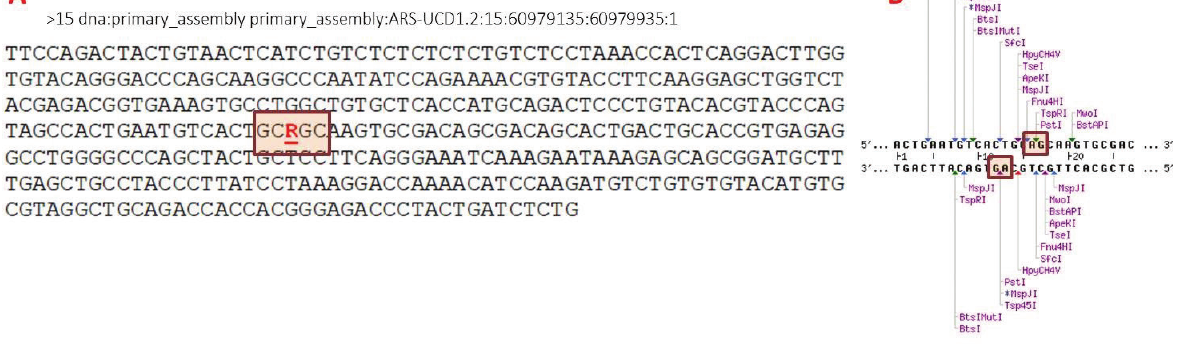
Figure 1: (A) The genomic location of the g.60979535A>G alteration in bovine FSHB gene concerning 200 bp flanking sequence. (https:// www.ensembl.org/Bos_taurus/Variation/Sequence?db=core;g=ENSBTAG00000010889;r=15:6097695260980910;t=ENSBTAT0000001446 2;v=rs207774587;vdb=variation;vf=70203212). (B) The Pst I restriction enzyme recognition site